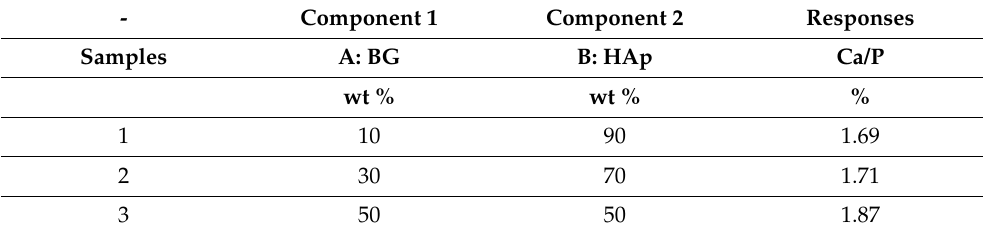
Table 5. EDX results of HAp/BG nanocomposites processed at 180 ◦ C.